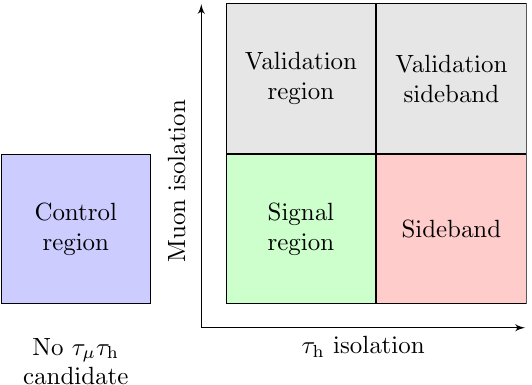
Figure 2 . Schematic of the (cid:12)t regions in the analysis. Events with two isolated muons and no (cid:28) (cid:28) candidates constitute the control region (blue). Events that have a (cid:28) (cid:22) h divided based on the isolation of the (cid:28) region (green) and the remaining (cid:28) (cid:22)(cid:22) candidates that fail the muon isolation selection form two analogous regions for the validation of the background (cid:12)t model